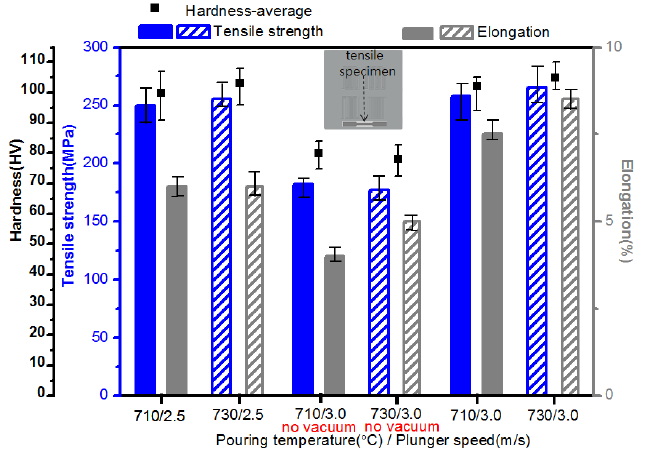
Figure 10. Mechanical properties of samples fabricated by vacuum die casting with different